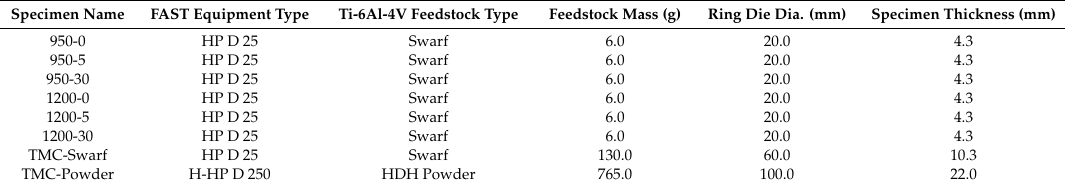
Specimen information for the field assisted sintering technology (FAST) processing cycles